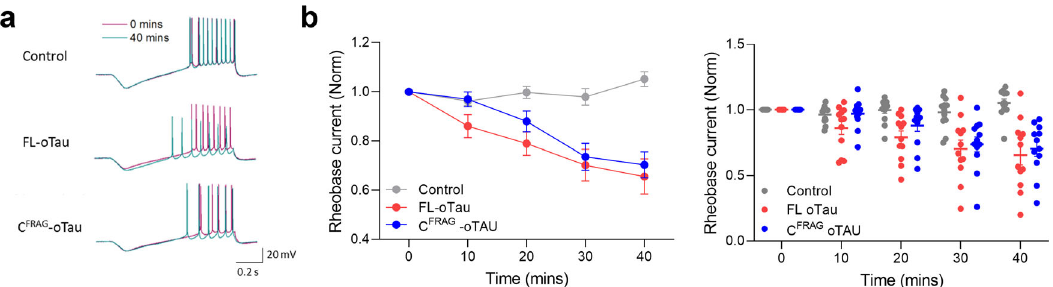
Fig. 3 FL-oTau and C FRAG -oTau reduce the rheobase (minimum current required to fi re an action potential). In the same recordings that are illustrated in Fig. 2, the rheobase current (minimal current to evoke an AP) was determined by injecting a current ramp ( − 50 to 200 pA) and measuring the minimum current required to fi re an action potential. a Example voltage responses to ramp current injections in control (vehicle) neurons where FL-oTau was injected and neurons where C FRAG -oTau was introduced. The voltage responses are shown at zero min (whole-cell breakthrough) and after 40 min of recording (the traces are superimposed). There was no change in control recordings (vehicle) but there is a clear negative shift (reduction in current required to fi re an action potential) for both tau species. b Graph plotting the mean rheobase current for control (vehicle), FL and C FRAG -tau oligomers against time (mean ± SEM) and the corresponding individual data points. There was no signi fi cant difference in rheobase in control, FL or C FRAG neurons at time 0 (whole-cell breakthrough) using a Kruskal – Wallis one-way ANOVA (at 0 min, the mean rheobase in control was 61 ± 3.47 pA, with FL the mean rheobase was 68 ± 5.39 pA and with C FRAG the mean rheobase was 79 ± 7.74 pA, P = 0.1289). In control neurons, there was no signi fi cant difference in the rheobase current over the duration of the recording (at 40 min, the rheobase was 105 ± 3% of the value at time 0 min, P = 0.0830, Table 1). However, both FL and C FRAG -tau oligomers signi fi cantly reduced the current needed to elicit an action potential. For FL-oTau, at 40 min the rheobase was 66 ± 7% of the value at time 0 min ( P = 0.0015). When C FRAG -tau was introduced, at 40 min the rheobase was 70 ± 5% of the value at time 0 min ( P = 0.0005, Table 1). Error bars represent the standard error of the mean (SEM).